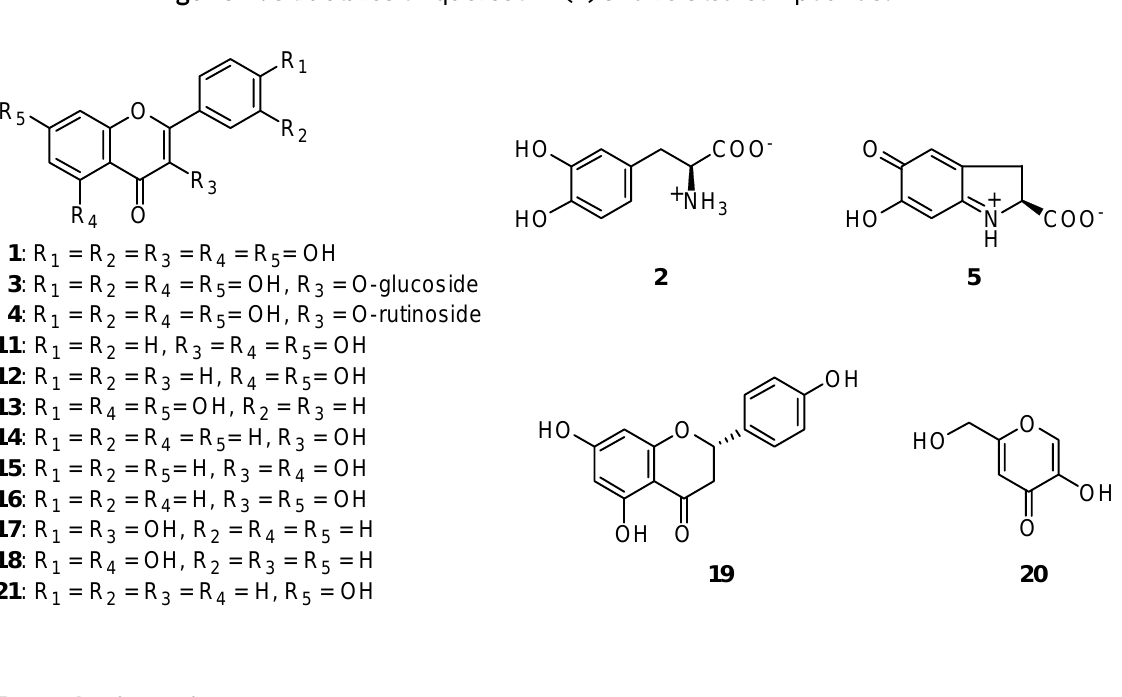
Figure 1. Structures of quercetin ( 1 ) and related